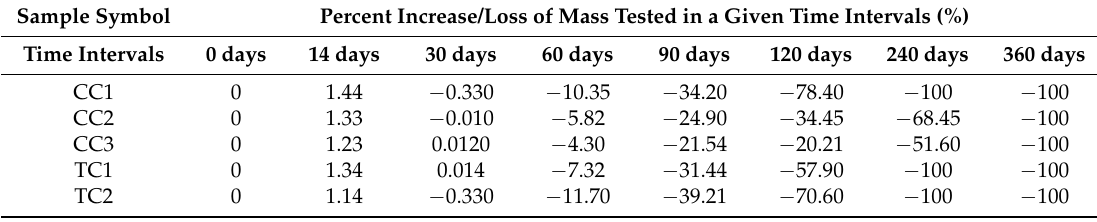
Table 9. Changes in mass of samples.